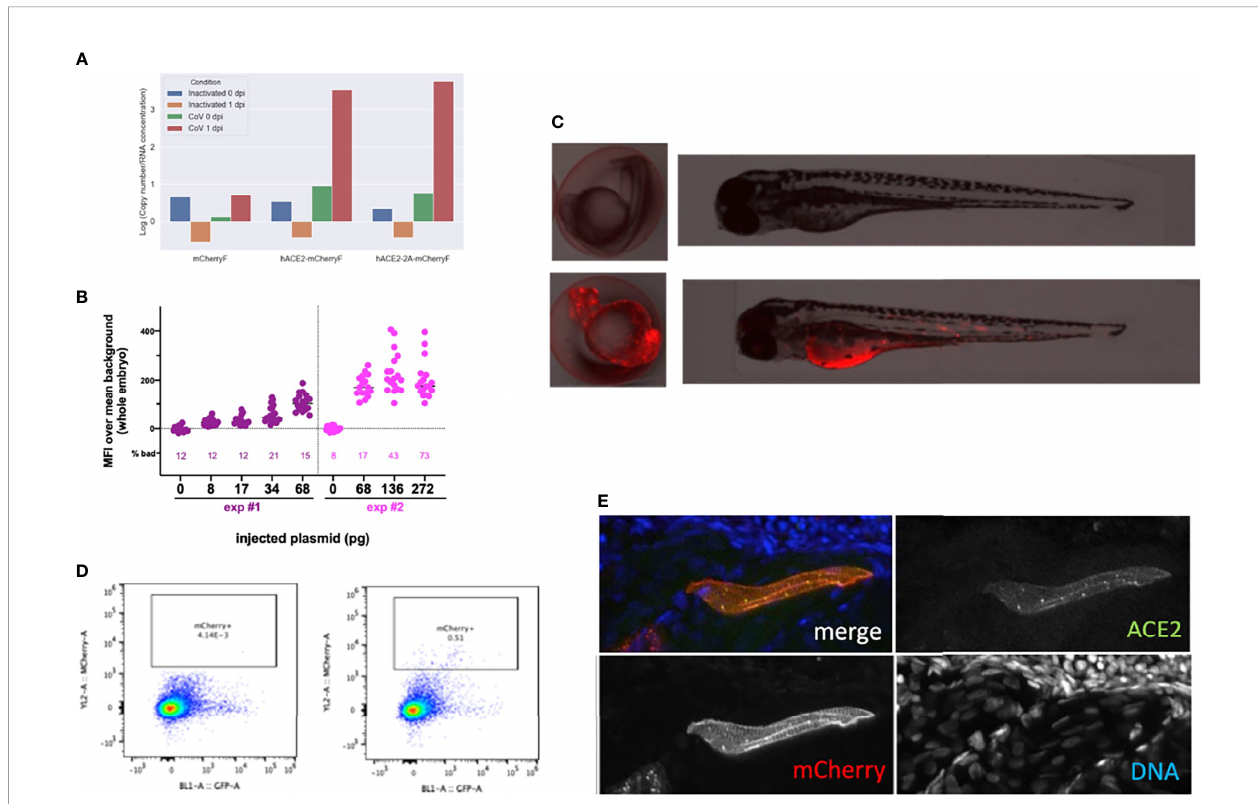
FIGURE 9 | Overexpression of hACE2-mCherry by plasmid injection at the 1-cell stage. (A) Veri fi cation of construct functionality by transfection in BHK cells. N mRNA levels measured 24 h after exposure of transfected cells with inactivated or with active SARS-CoV-2. (B) Optimization of the plasmid dose. Fluorescence intensity measured in 24-hpf embryos after injection at the 1-cell stage of the speci fi ed amount of the pz26hACE2-mCherryF plasmid together I-SceI, for the 25% embryos with the best expression in each group. The percentage of misshapen embryos in each group is indicated on the bottom of the graph. (C) representative image of a 24-hpf embryo (left) and a 3-dpf larva (right) after mock injection (top) or injection of 68 pg of pz26hACE2-mCherryF. (D) Representative fl ow cytometry analysis of cells dissociated from 4-dpf larvae, mock-injected (left) or injected with 68 pg of pz26hACE2-mCherryF (right). (E) Immunohistochemistry of a larva injected with 68 pg of pz26hACE2-2A-mCherryF, showing ACE2 detection of a mCherry-positive muscle fi